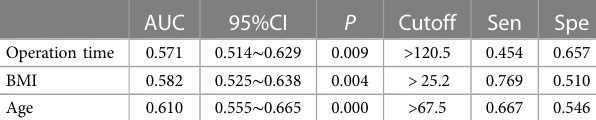
TABLE 2 The AUC of continuous variables were investigated by using univariate analysis. AUC